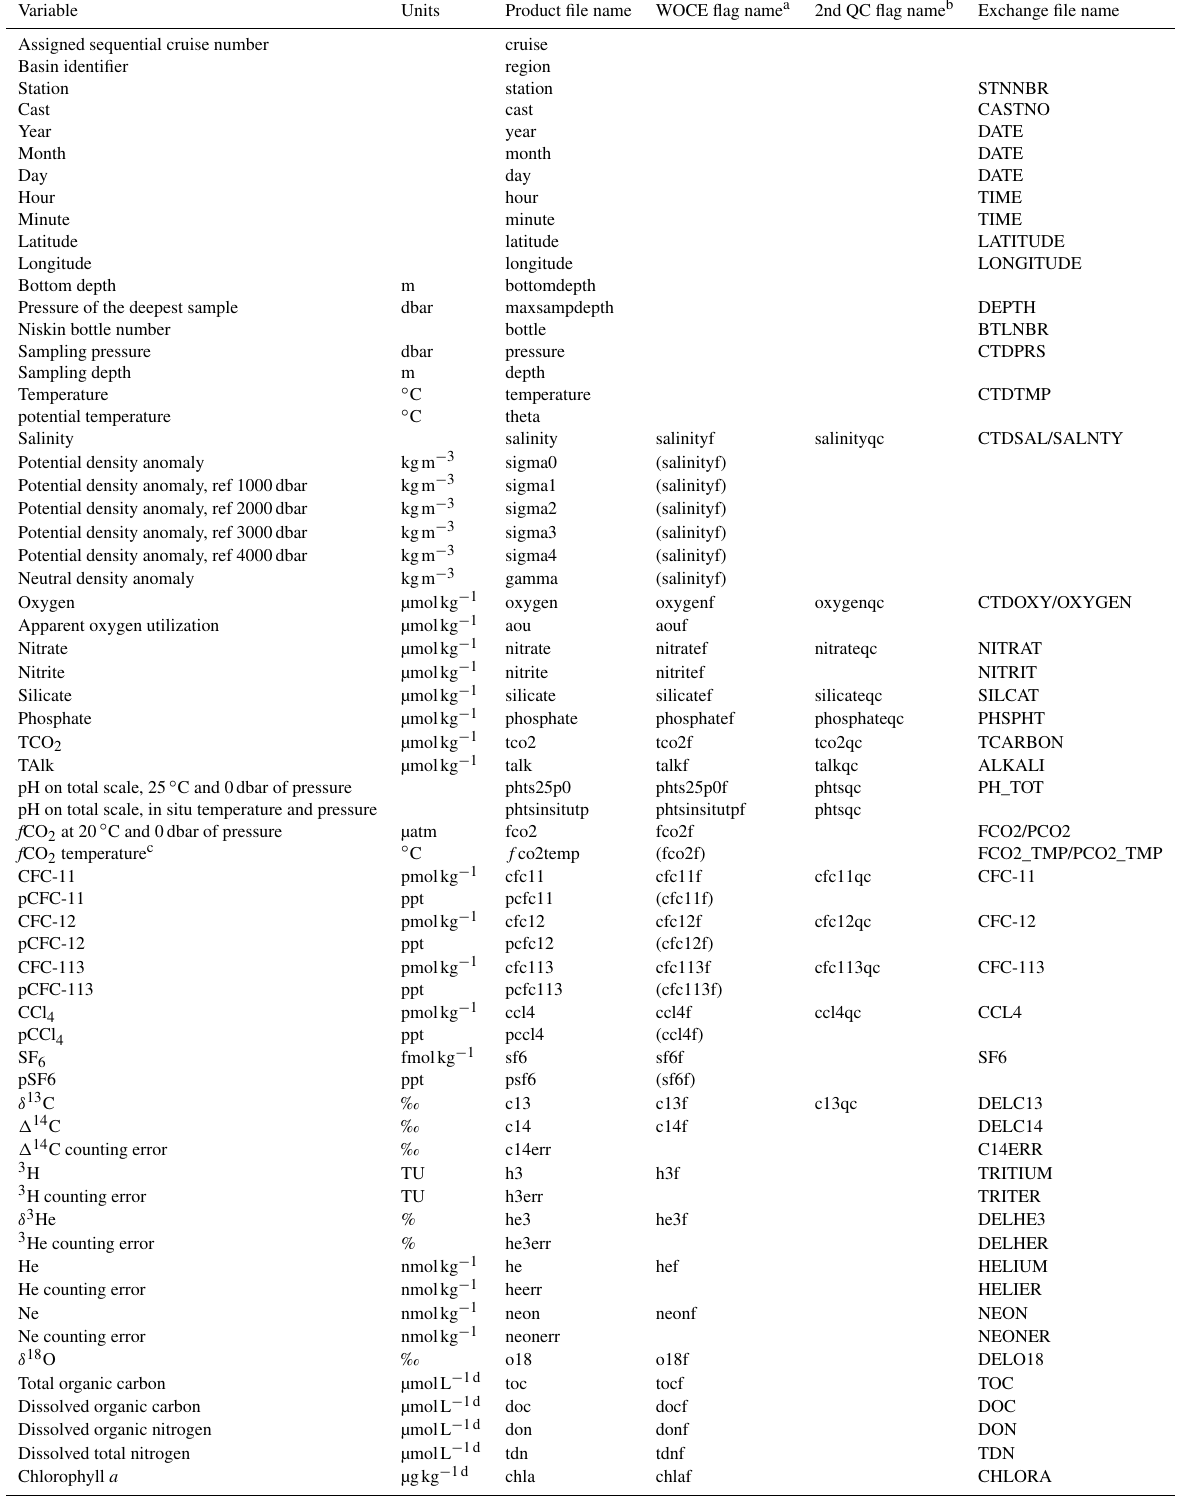
Table 1. Variables in the GLODAPv2.2021 comma separated (csv) product files, their units, short and flag names, and corresponding names in the individual cruise exchange files. In the MATLAB product files that are also supplied a “G2” has been added to every variable name.